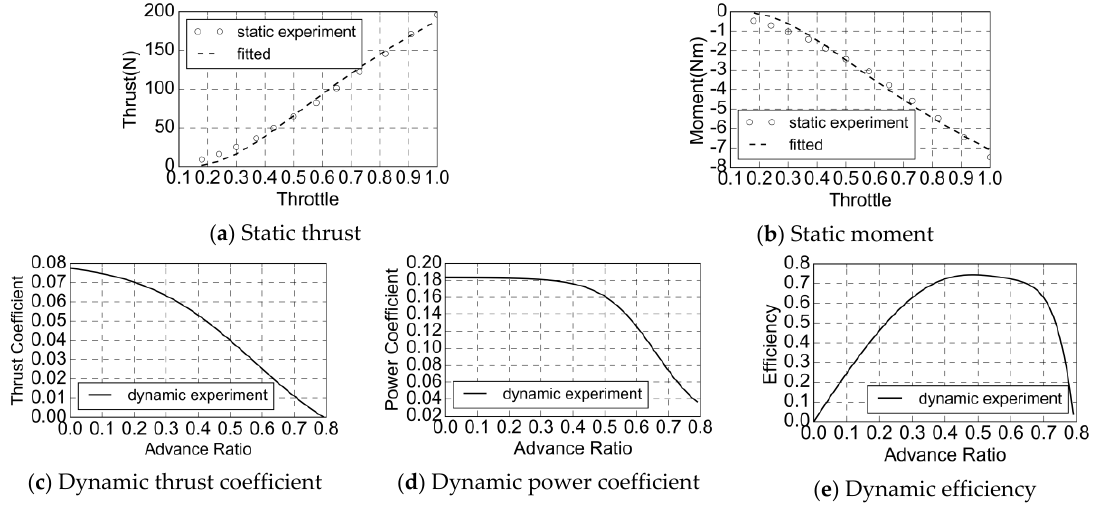
Figure 5. The static and dynamic experiment data.